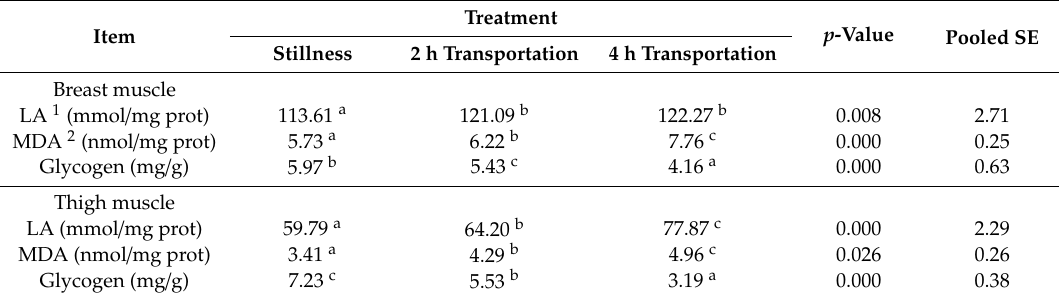
p -Value Pooled SE